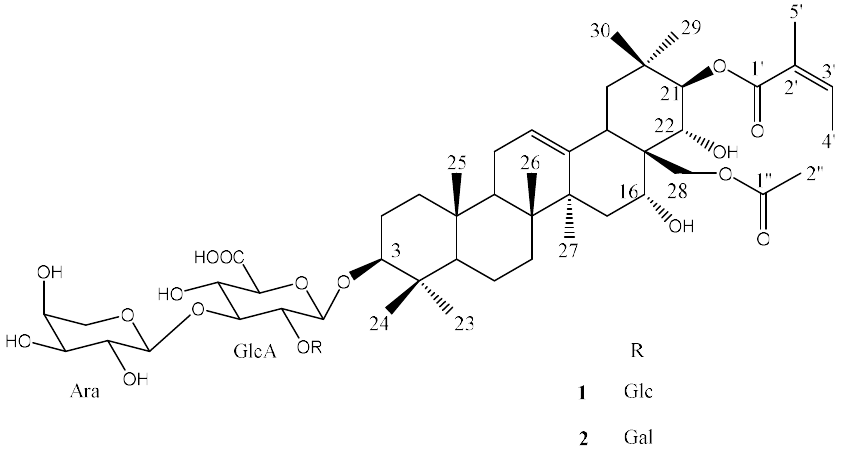
Figure 1. Structures of compounds 1 and 2 .